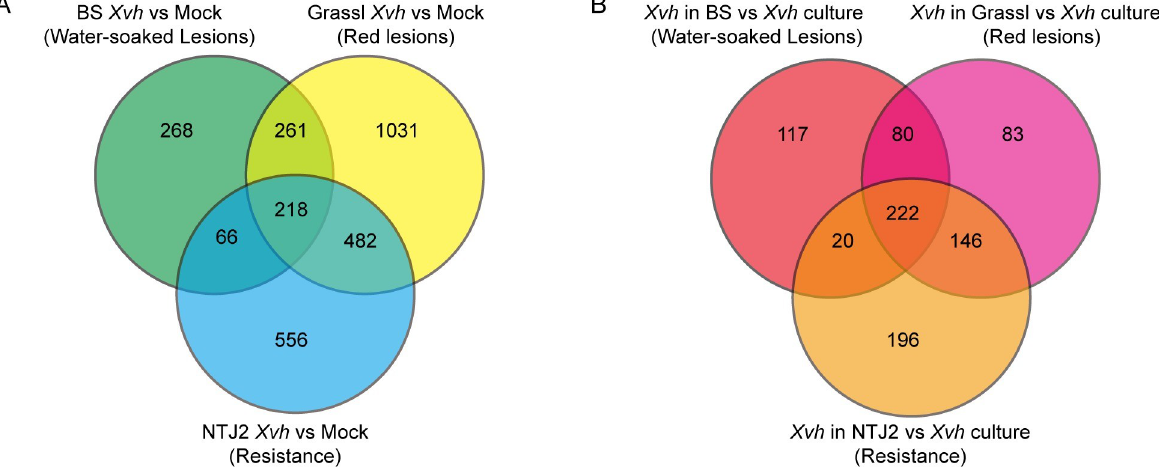
Fig 6. Venn diagram showing the number of differentially expressed genes (FDR adjusted p < 0.05; |log 2 fold change| > 2). A) Sorghum; B), Xvh . Complete gene lists are provided in S3 and S4 Tables. BS (water-soaked lesions), Grassl (red lesions), and NTJ2 (resistance).